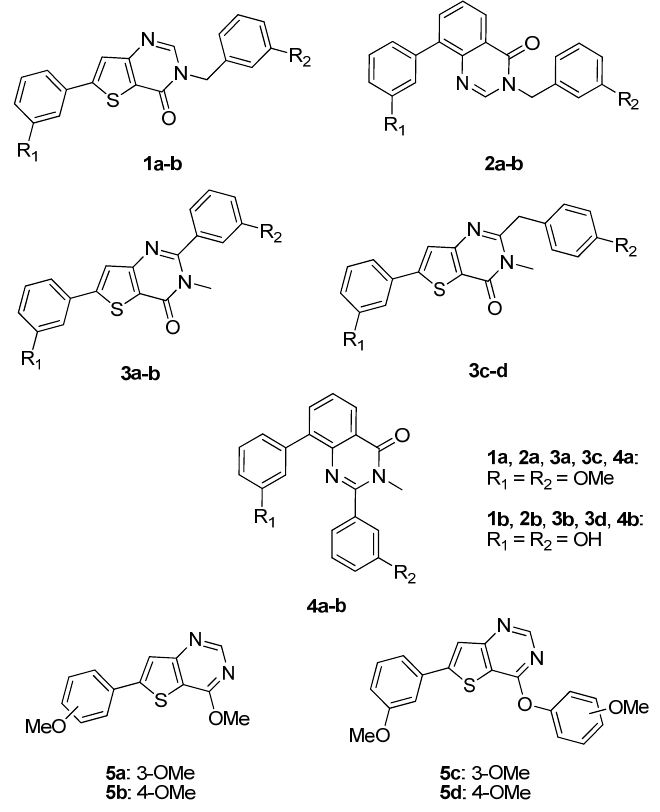
Figure 3. Thieno[3,2- d ]pyrimidin-4-ones 1a – b , 3a – d and thieno[3,2- d ]pyrimidine 5a – d as conformationally restrained analogues of conformer I and III , and quinazolin-4-one 2a – b , 4a – b as conformationally restrained analogues of conformer II and IV ,